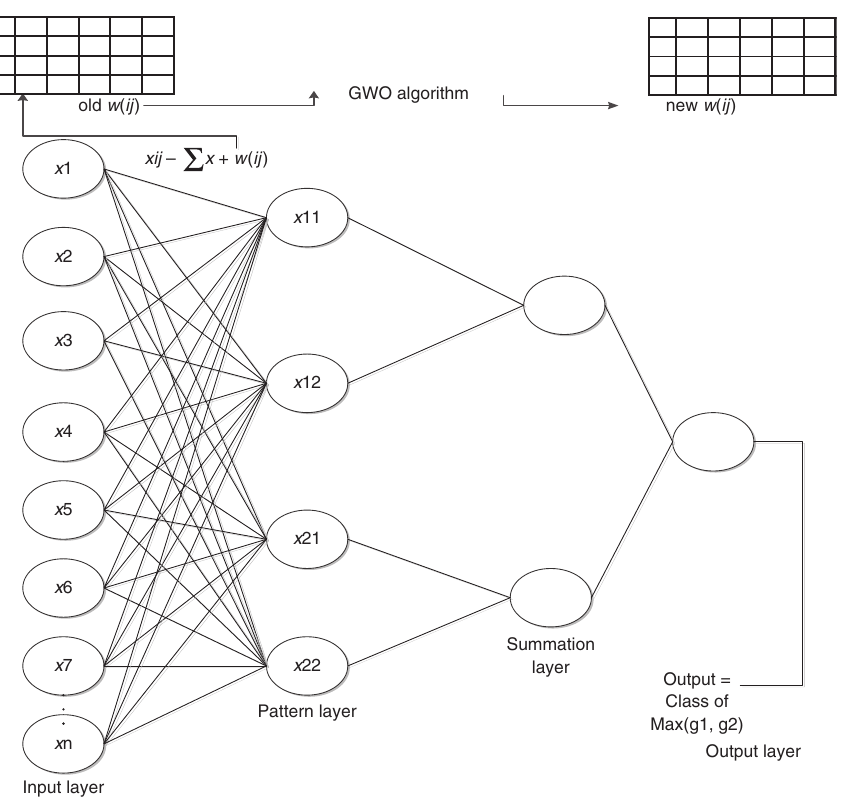
Figure 2: Mechanism of GWO Algorithm with